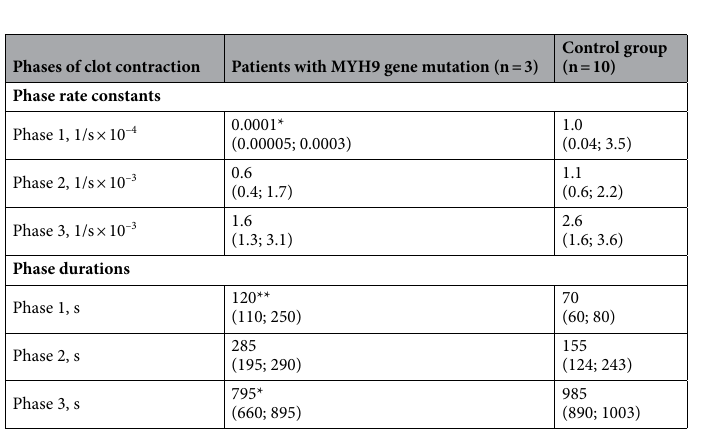
Table 3. Comparative phase analysis of the averaged kinetic curves of blood clot contraction for patients with a MYH9 gene mutation and healthy subjects (control). The results are presented as the median